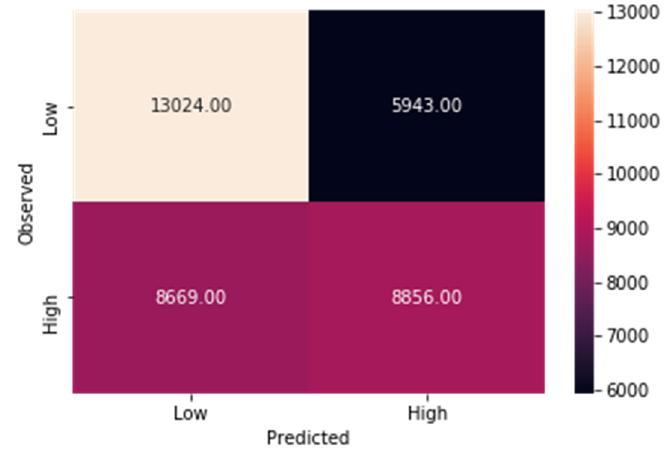
Figure A3. Boxplots of author number ( left ) and title length ( right ) by document type. The plots show that reviews have significantly fewer authors and significantly shorter titles. The whiskers of the plots corresponds to 1.5× the interquartile range. Values falling outside of this intervals are represented as black dots.